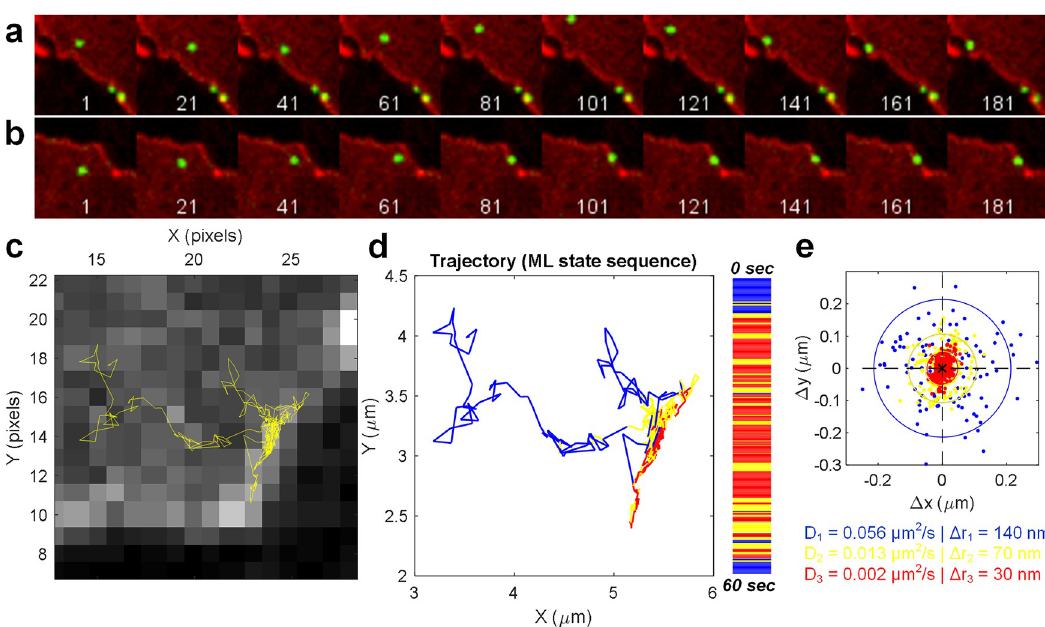
Fig 8. Dynamic retention of diffusing DAT-Qdots at the cell edge, an area of local DAT accumulation. (a-b) Representative time-lapse sequences showing transient trapping of DAT-Qdots at the cell edge, an area with increased local RFP-DAT density. Area size: 13x13 μ m. (c)A reconstructed trajectory depicting DAT-Qdot motion in b. Scale: 1 pixel = 0.22 μ m. (d) HMM Analysis of DAT-Qdot diffusive state swtiching over the course of the trajectory shown in c. Three distinct diffusive states were identified–fast (blue) occurring in the flat membrane regions, yellow and red (intermediate and slow) occurring in the vicinity of the cell edge and corresponding to transient DAT-Qdot trapping. (e) A scatter plot showing the distribution of instantaneous vector displacements ( Δ x, Δ y)corresponding to the three diffusive states identified in d. Source data are provided in S3 Dataset.